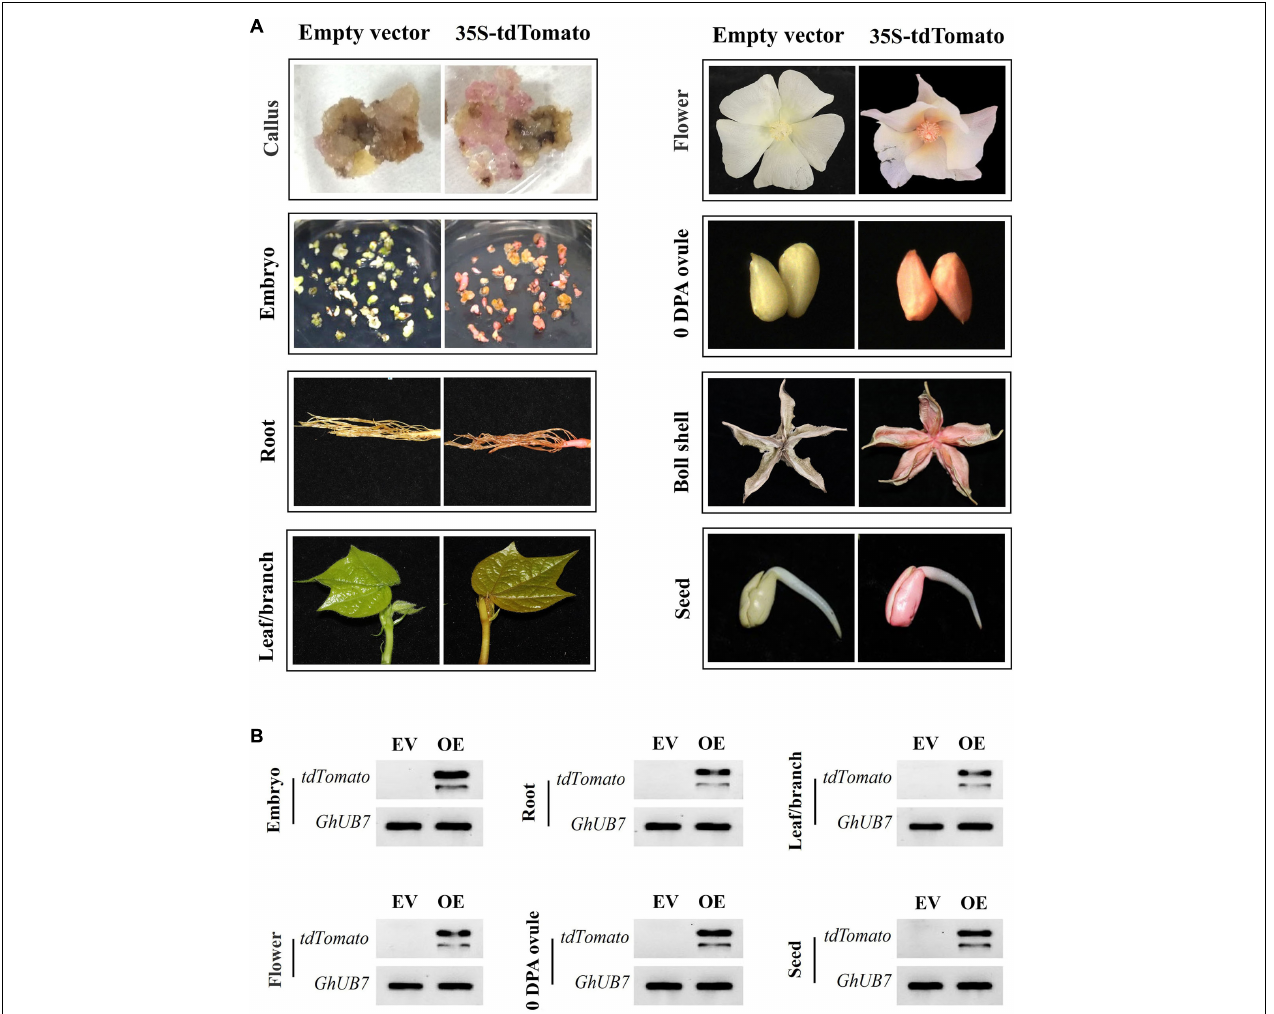
FIGURE 6 | The tdTomato protein serves as a visual marker for successful transgenic events. (A) The constitutive expression of tdTomato led to pink coloration in different tissues/organs of transgenic cotton materials. (B) RT-PCR analysis of tdTomato expression of transgenic cotton materials appearing pink. EV, empty-vector-transformed cotton materials; OE, tdTomato-overexpressing cotton materials; GhUB7 , the reference